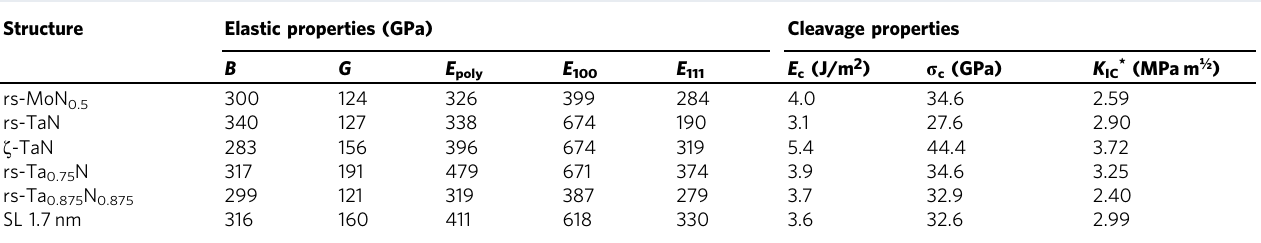
Table 2 Elastic properties and cleavage properties of the constituents of our superlattices as well as of the superlattice with a bilayer period of 1.72 nm.